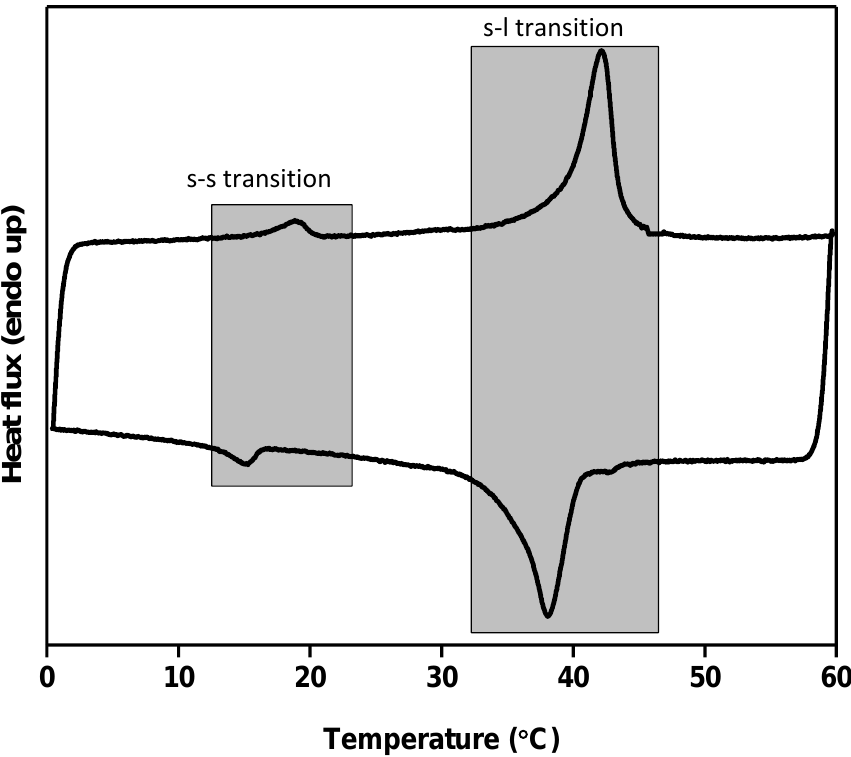
Figure 2. DSC scan of HDPE/Wax/EG (40/50/10).